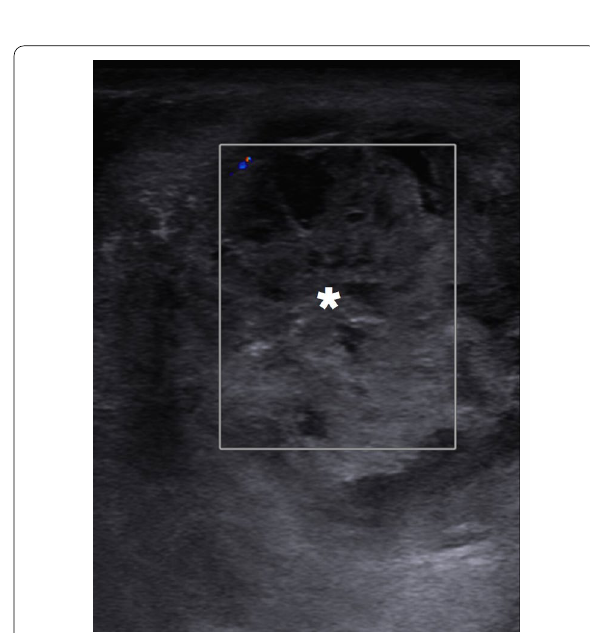
Fig. 10 Testicular choriocarcinoma. A 25-year-old male with an unremarkable past medical history presenting with right testicular palpable mass and mild tenderness. Color Doppler US shows a large heterogeneous solid mass (asterisk) with no apparent internal vascularity on color Doppler study. Differential diagnoses based on US findings were necrotic testicular tumor, testicular hematoma or testicular abscess. As the concomitant serum beta-hCG levels were extremely high (150.000 mlU/mL), a testicular choriocarcinoma was